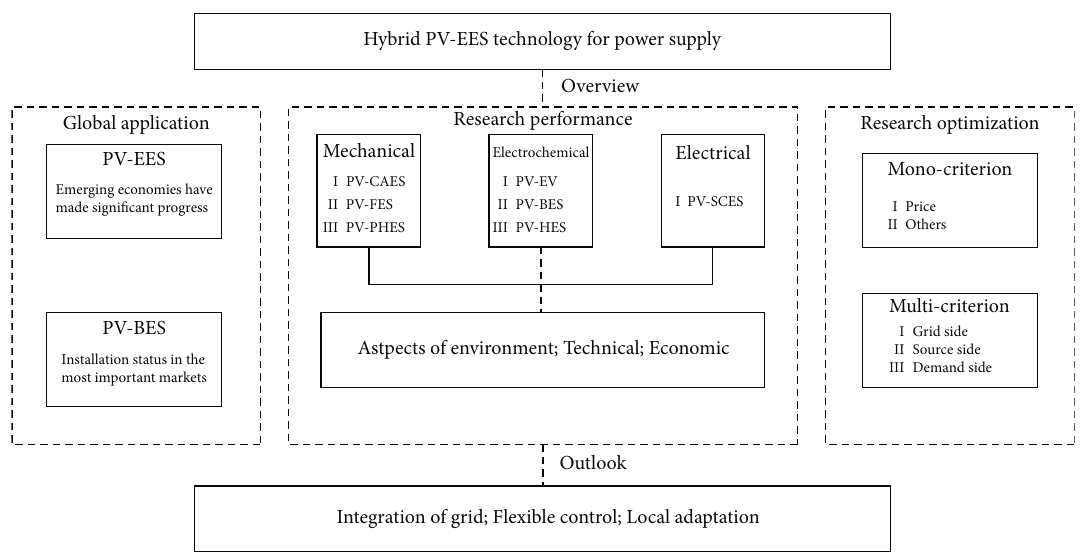
Figure 2: The hybrid of PV-EES technologies ’ main objective for grid